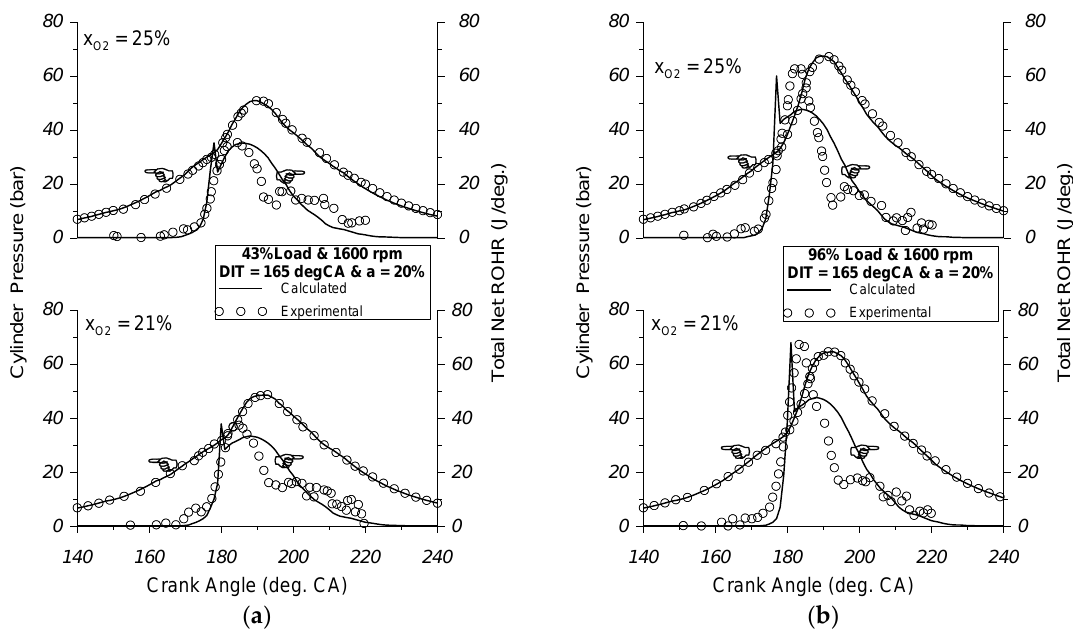
Figure 2. Comparison between experimental and computed cylinder pressure and total RoHR traces of the test engine for “x O2 ” = 21% and 25% & “a” = 20%, operating at 43% of engine rated load & 1600 rpm engine speed ( a ); and 96% of engine rated load & 1600 rpm engine speed ( b ).